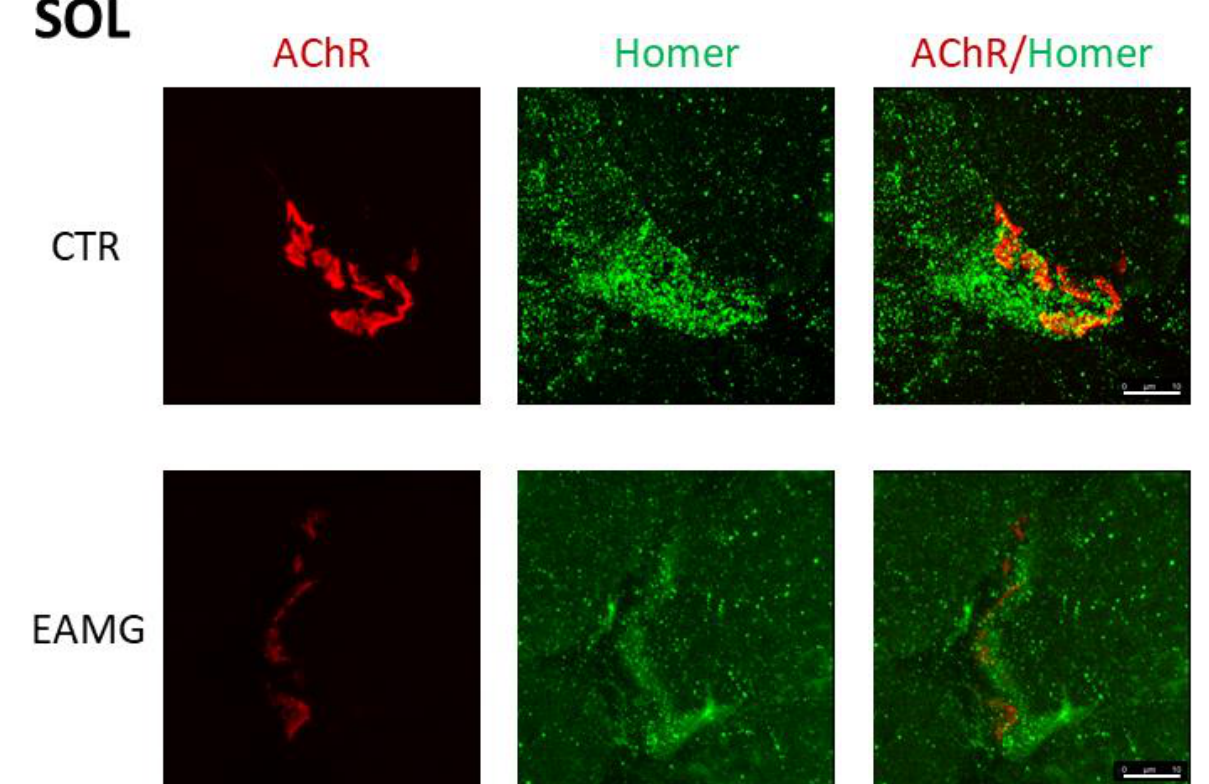
Figure 3. Representative immunohistochemical staining of SOL muscle endplates and endplate-adjacent Homer protein. SOL endplate-AChRs stained with α -Bungarotoxin ( red ), Homer protein stained with Pan-Homer-antibody ( green ). Right picture: merged AChR- and Homer-staining. Upper panel represents CTR-group, lower panel EAMG group. Confocal images display maximum projection of z-stacks of endplates scanned. Z-stacks are merged via 3D-analysis software and analysed for pixel intensity and volume. Magnification bar = 10 µm.